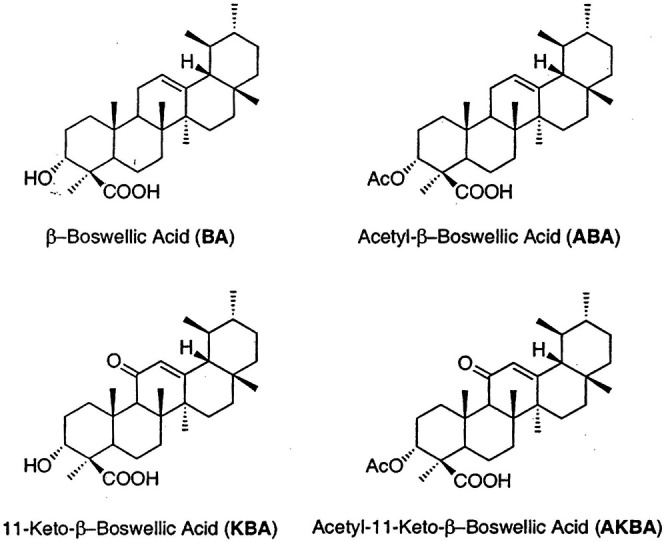

(A) β-Boswellic Acid (BA). (B) Acetyl β-Boswellic Acid (ABA). (C) 11-Keto-β-Boswellic Acid (KBA). (D) Acetyl-11-Keto-β-Boswellic Acid (AKBA).